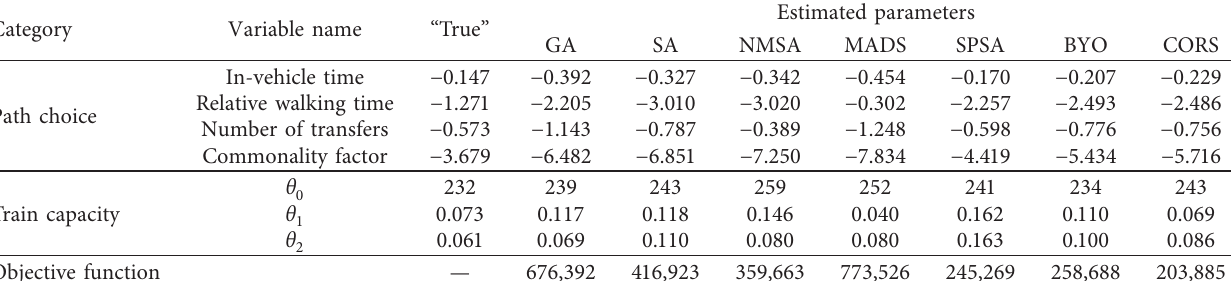
Table 4: Estimation results of the reference scenario.